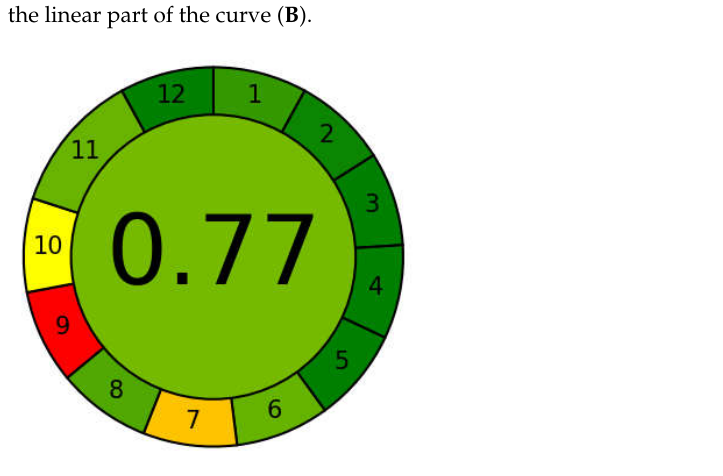
Figure 5. Agree pictogram for evaluation of the proposed method greenness.